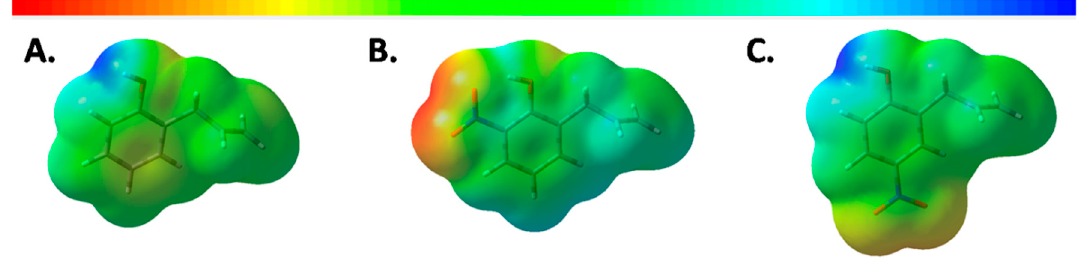
Figure 3. Charge distribution map: ( A ) compound 1 ; ( B ) compound 4 ; ( C ) compound 8 . Red and blue represent negative and positive charges, respectively. Charge variation is represented by intermediate colors.